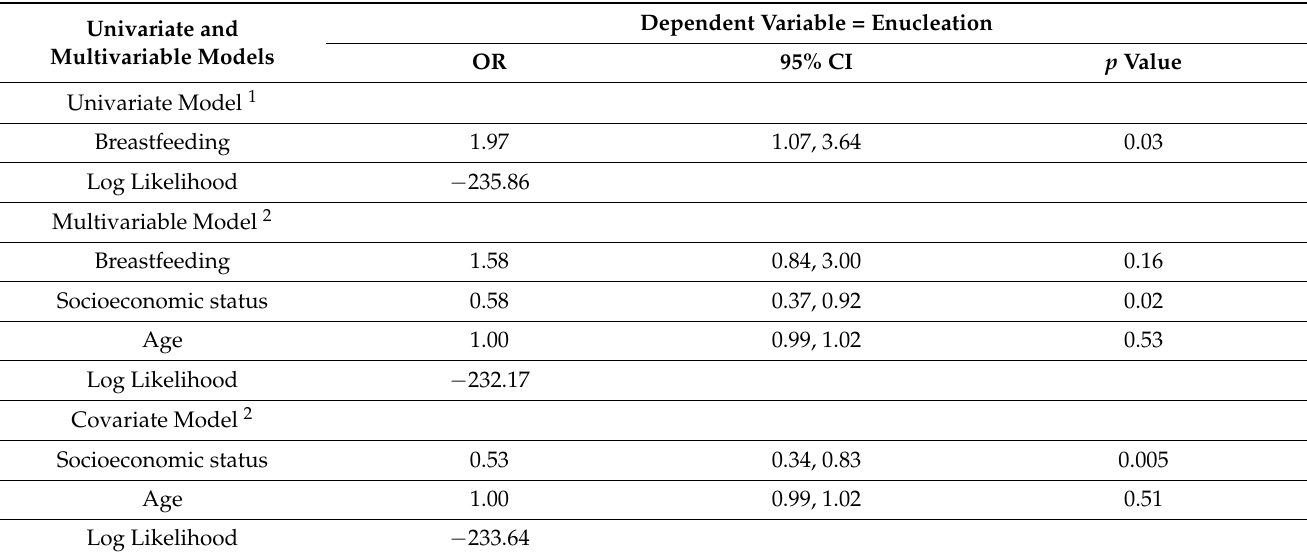
Table 3. Univariate and multivariable model statistics for